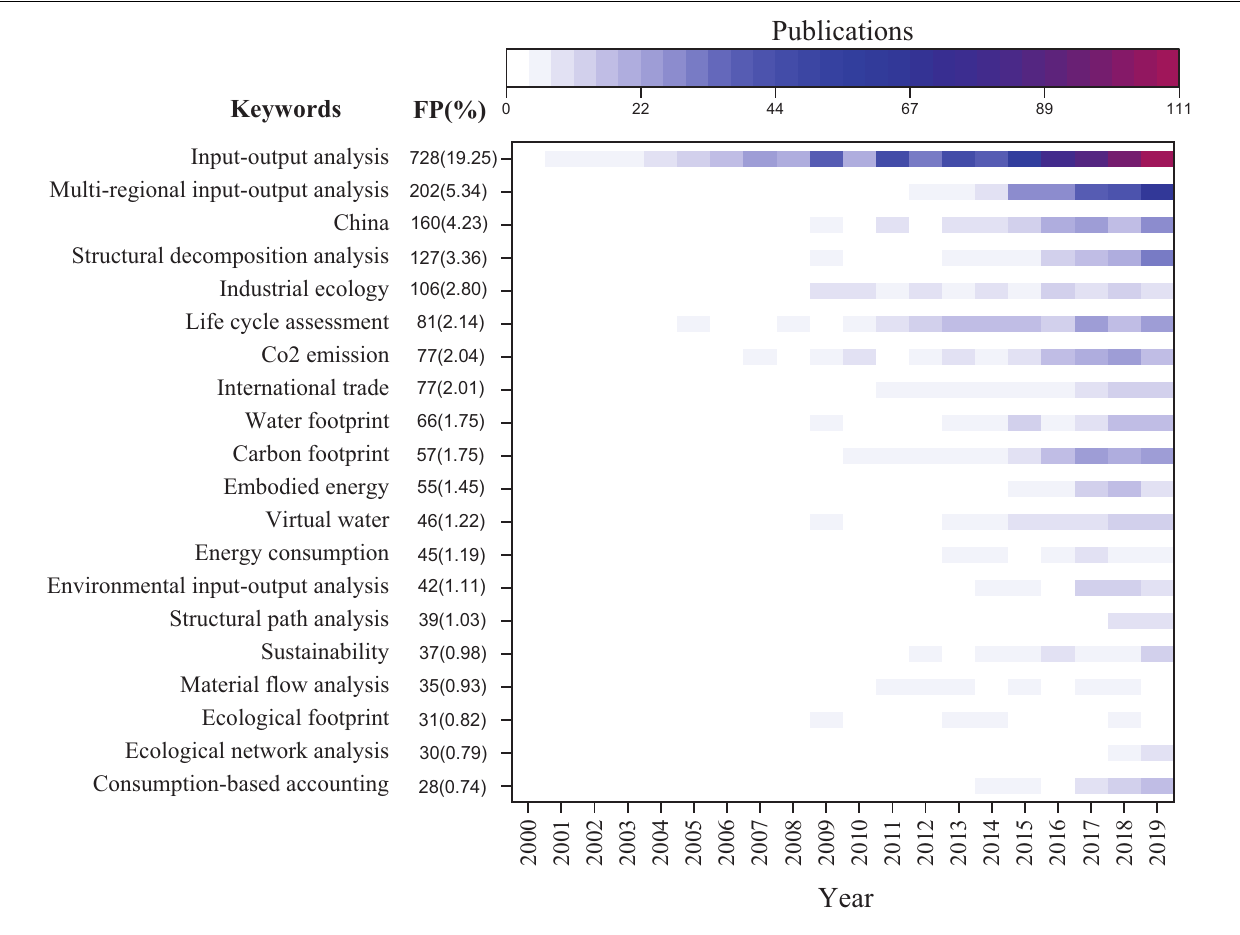
consumption-based perspective. The results show that the use